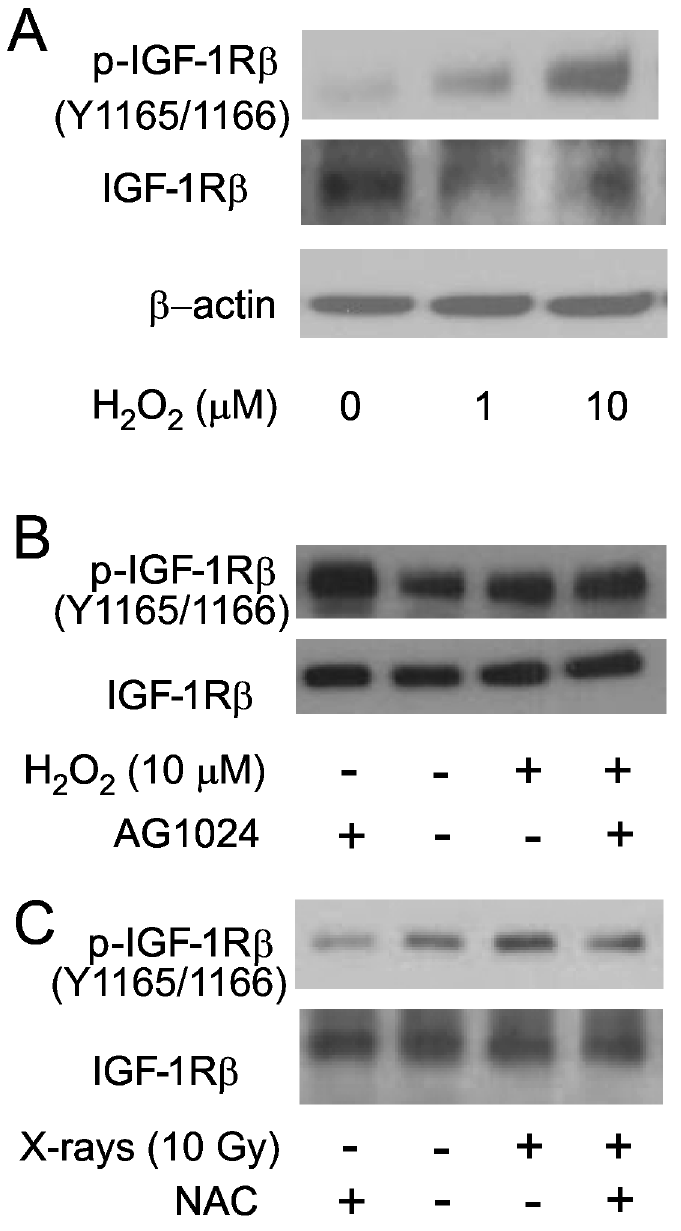
Figure 6. H O induces phosphorylation of IGF-1R. (A) Subconfluent HPAEC were treated with 1 μM and 10 μM H 2 2 incubated in a CO incubator. After 20 minutes, whole cell lysates were prepared and western blotting was performed to determine 2 the phosphorylation status of IGF-1R. (B) HPAEC were treated with 5 μM AG1024 for 30 minutes and then with 10 μM H minutes. Western blotting was then performed to determine phosphorylation status of IGF-1R. (C) HPAEC were treated with 20 mM NAC and subjected to 10 Gy X-rays. Western blotting was then performed 3 hours post-irradiation to determine phosphorylation status of IGF-1R.